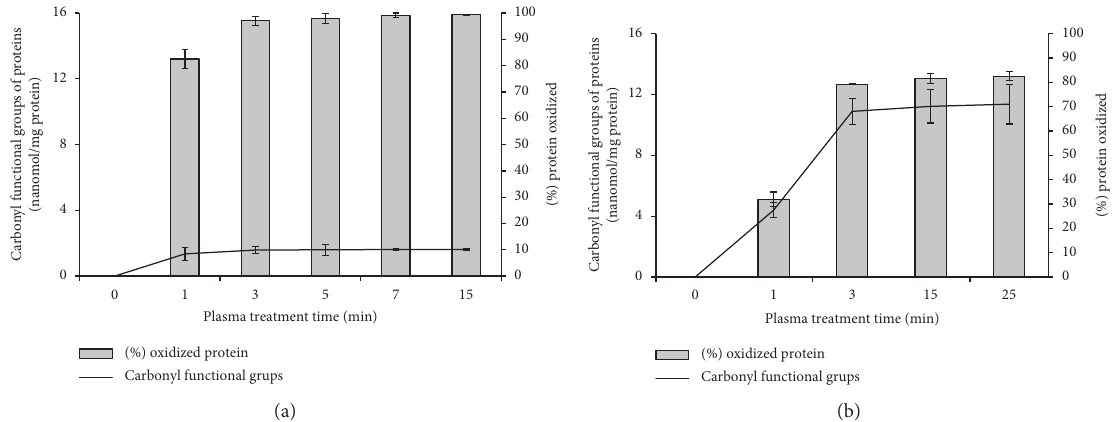
Figure 5: Protein oxidation damage after CP treatment. (a) Treatment with CP of Adobera cheese. (b) Treatment with CP in free